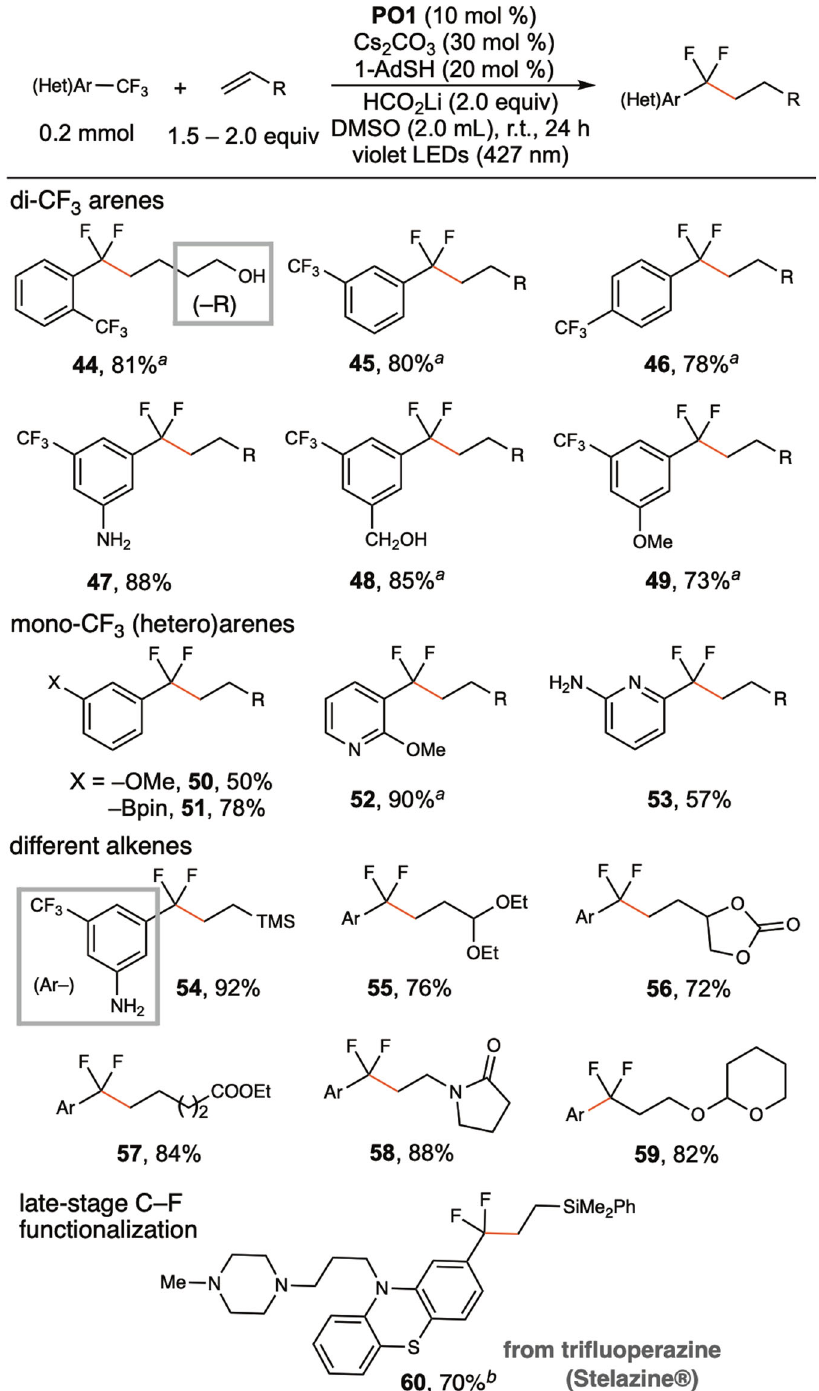
Fig. 7 Scope of de fl uoroalkylation of tri fl uoromethyl(hetero)arenes. Yields of isolated products. a KO t Bu (30 mol %). b PO3 (10 mol %) instead of PO1 , alkene (0.6